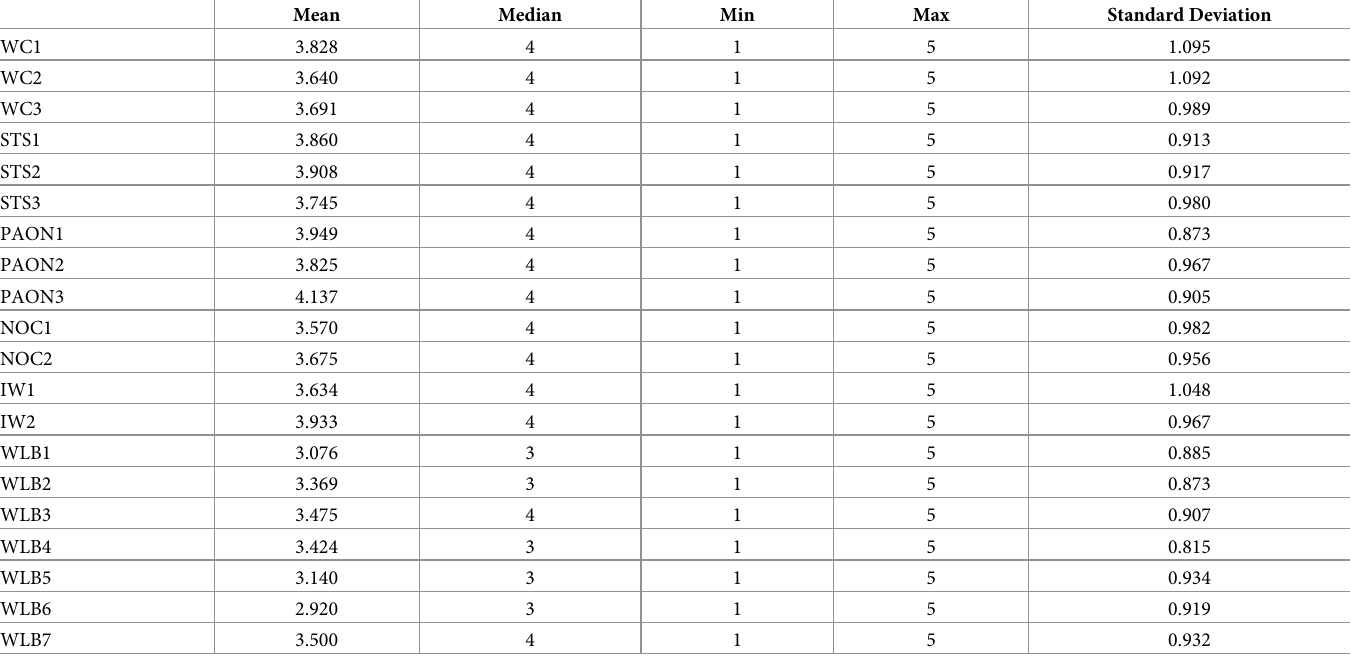
Table 1. Descriptive statistics of indicators’